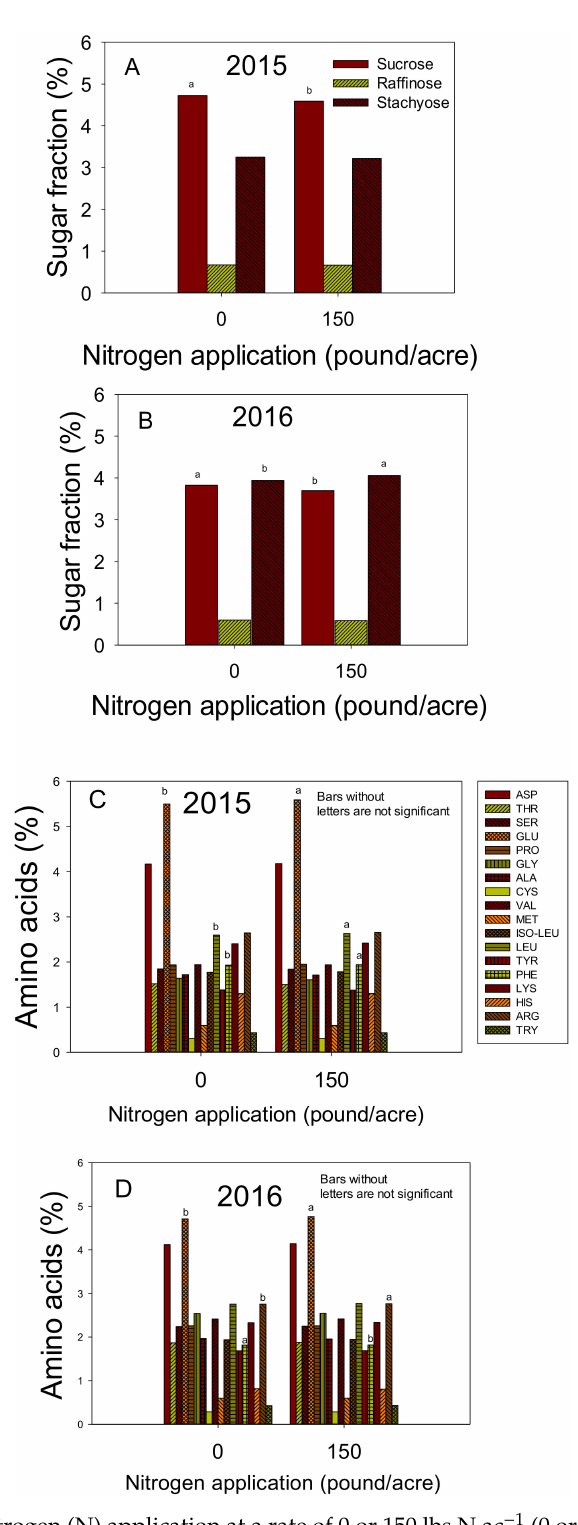
Figure 3. E ff ect of nitrogen (N) application at a rate of 0 or 150 lbs N ac − 1 (0 or 168 kg ha − 1 ) on seed sugars (sucrose, ra ffi nose, and stachyose) (%) in 2015 ( A ) and 2016 ( B ); E ff ect of nitrogen (N) application at a rate of 0 or 150 lbs N ac − 1 (0 or 168 kg ha − 1 ) on seed amino acids (%) in 2015 ( C ) and 2016 ( D ). Bars with the same colors and patterns with di ff erent letters are significantly di ff erent at P ≤ 0.05. Bars without letters are not